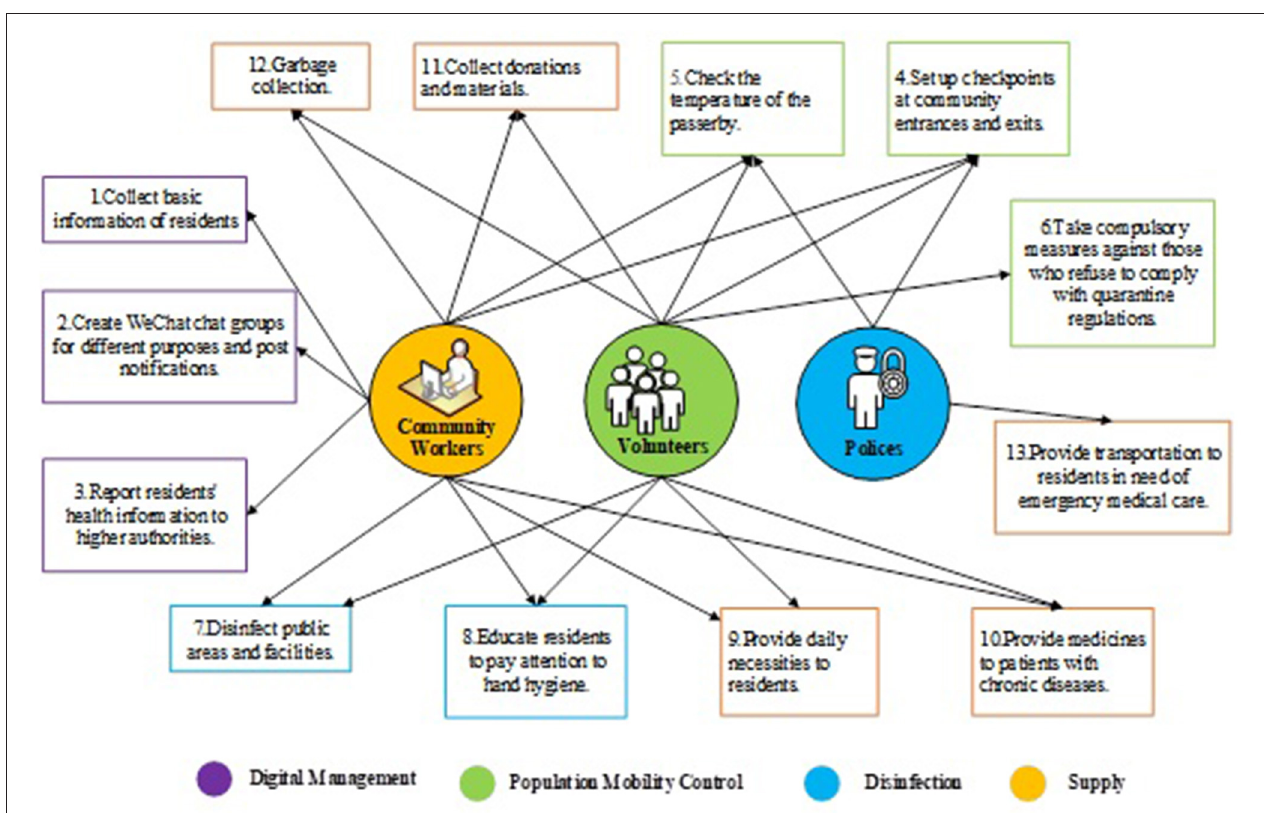
FIGURE 1 | Work content of staffs of the epidemic prevention and control in the